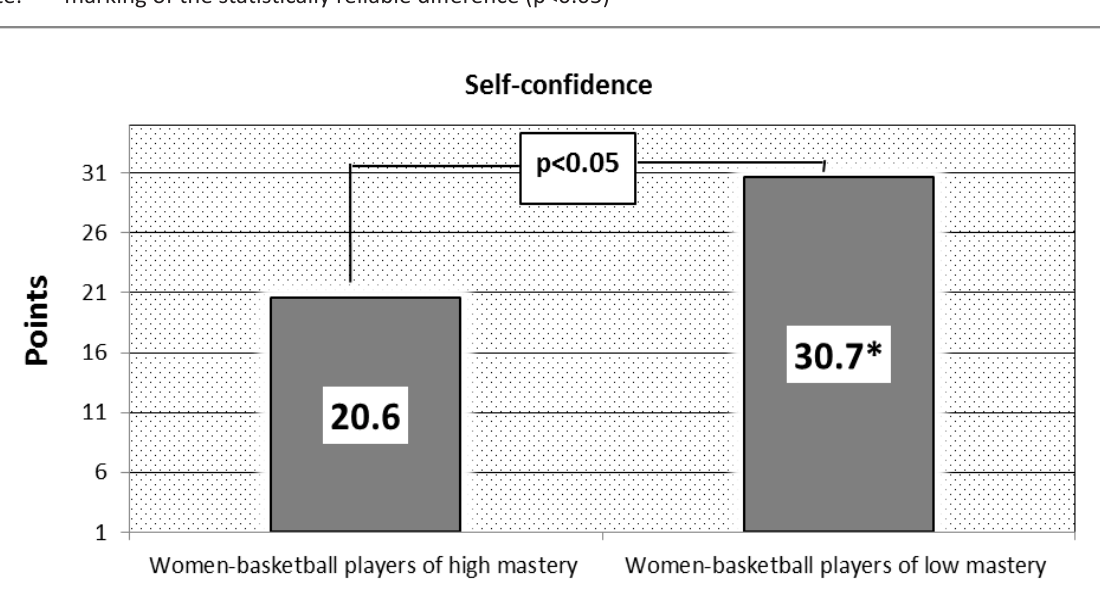
Fig. 3. Distribution of self-confidence indexes of women-basketball players of different mastery (in points) Note: * – marking of the statistically reliable difference (p<0.05)